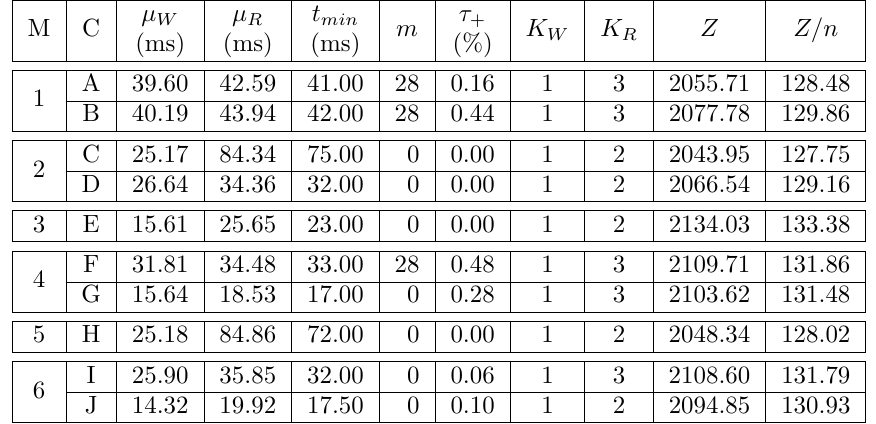
Table 1: Experimental results with n = 16 (pseudo-random) bytes of plaintext. (M: manufacturer, C: card)